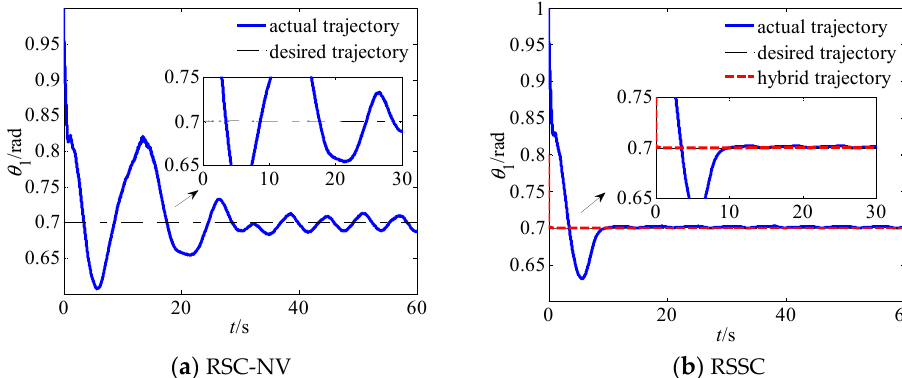
Figure 3. Trajectory tracking curve of the system joint O 1 .